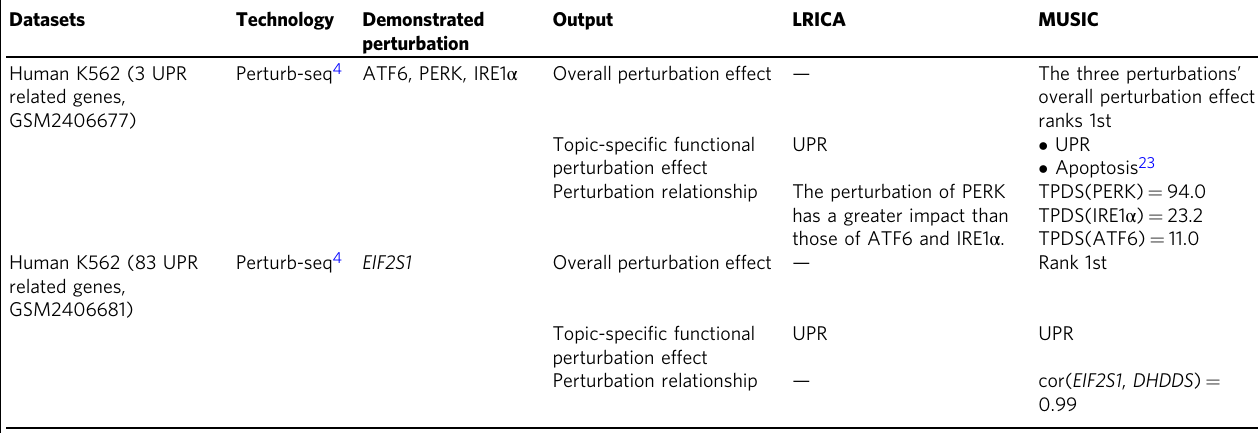
Table 2 Comparison of detail analysis results between MUSIC and LRICA Datasets